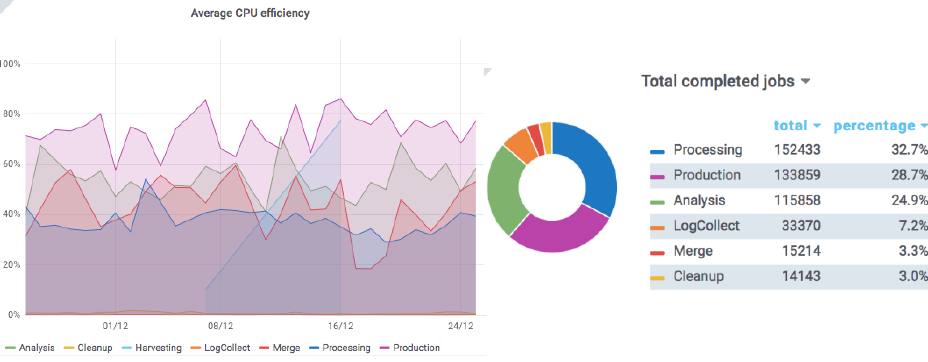
Figure 2a: The average CPU efficiency of RAL jobs Figure 2b - the number of each job